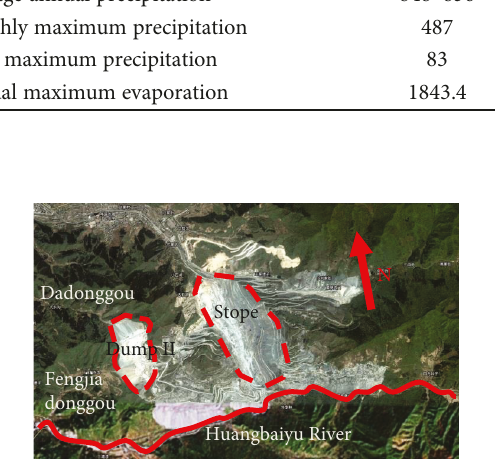
Figure 2: Mining area